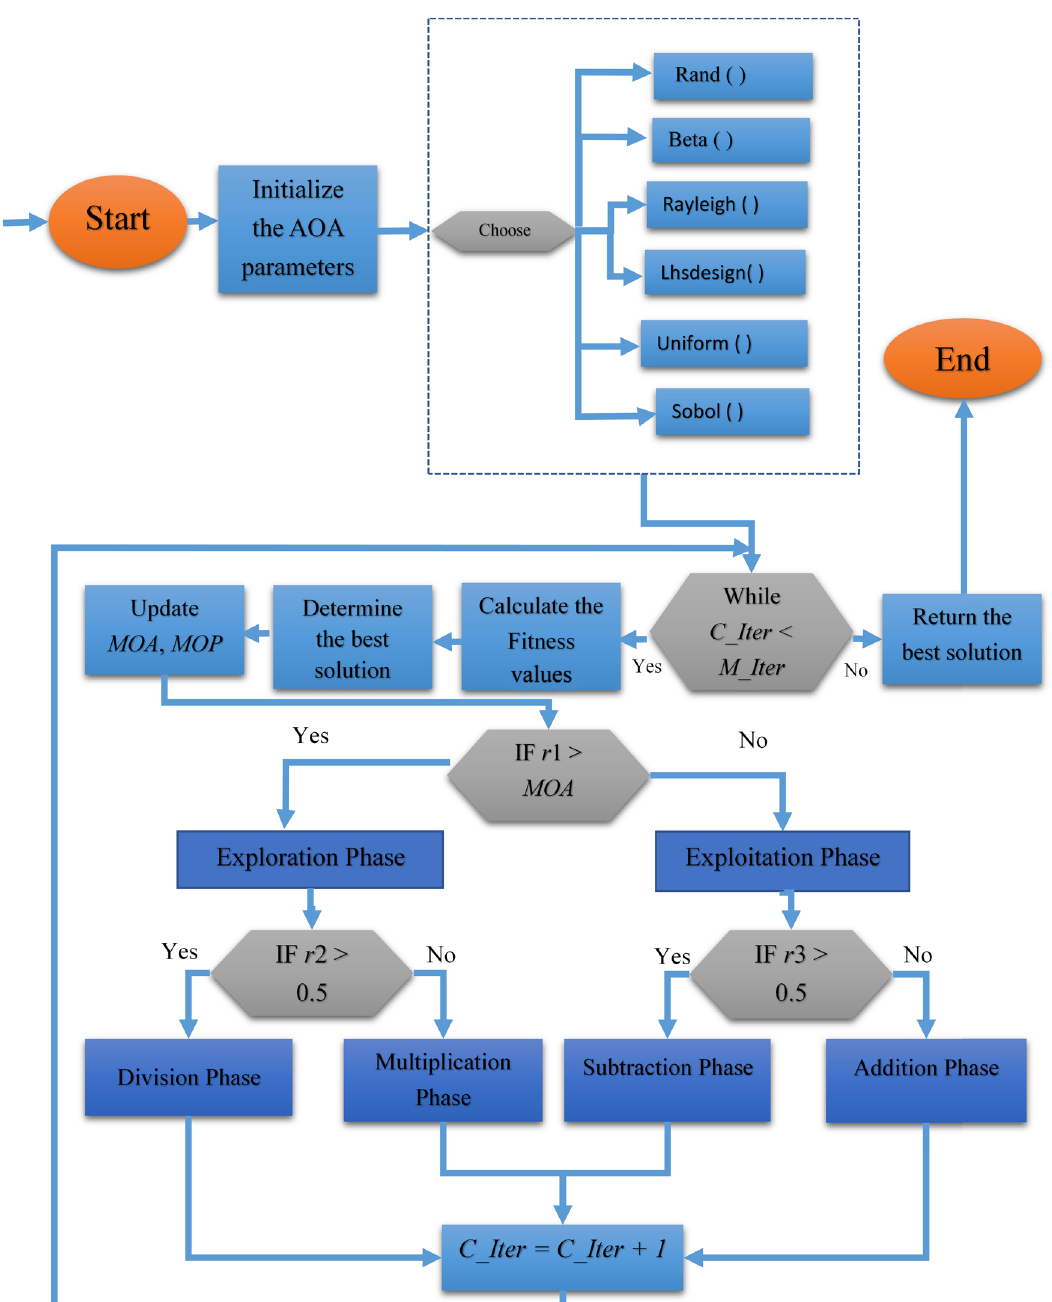
Figure 3: The modi fi ed fl owchart for AOA